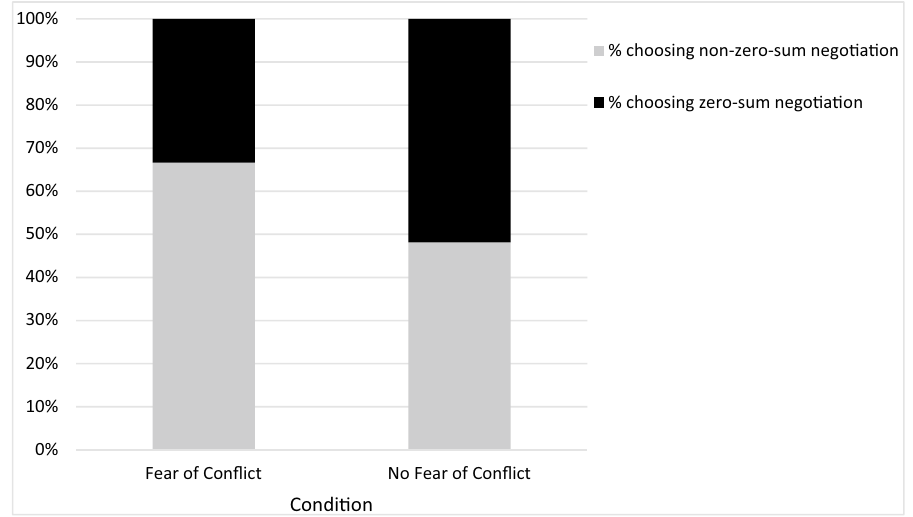
Figure 4. Participants’ choice to join a zero-sum and a non-zero-sum negotiation as a function of their concern about conflict (Study